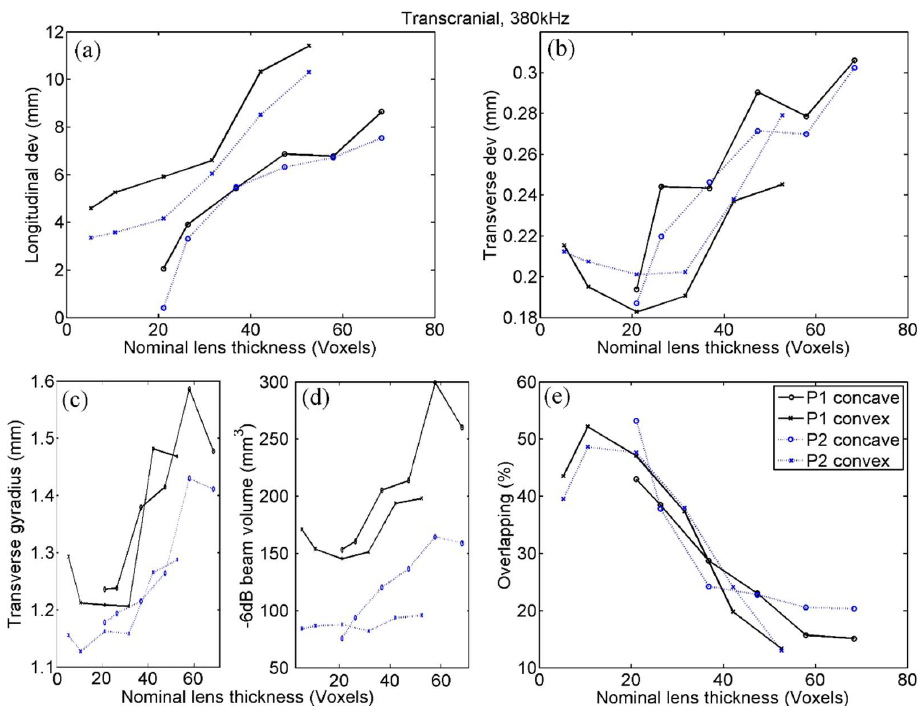
Figure 8. Focusing quality indicators calculated by transcranial simulation with 380 kHz at points P1 and P2, for concave (fast) and convex (slow) lenses. Indicators are as follows: ( a ) Longitudinal and ( b ) transverse deviation, ( c ) transverse gyradius, ( d ) beam volume, and ( e ) energetic overlapping.